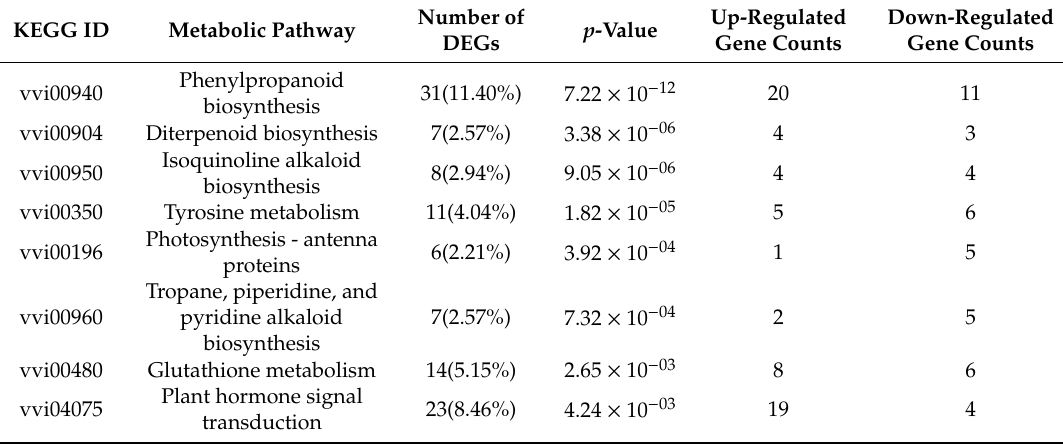
Table 3. Metabolic pathways significantly enriched for differentially expressed genes (DEGs) in the russet CKY versus non-russet CKN comparison.